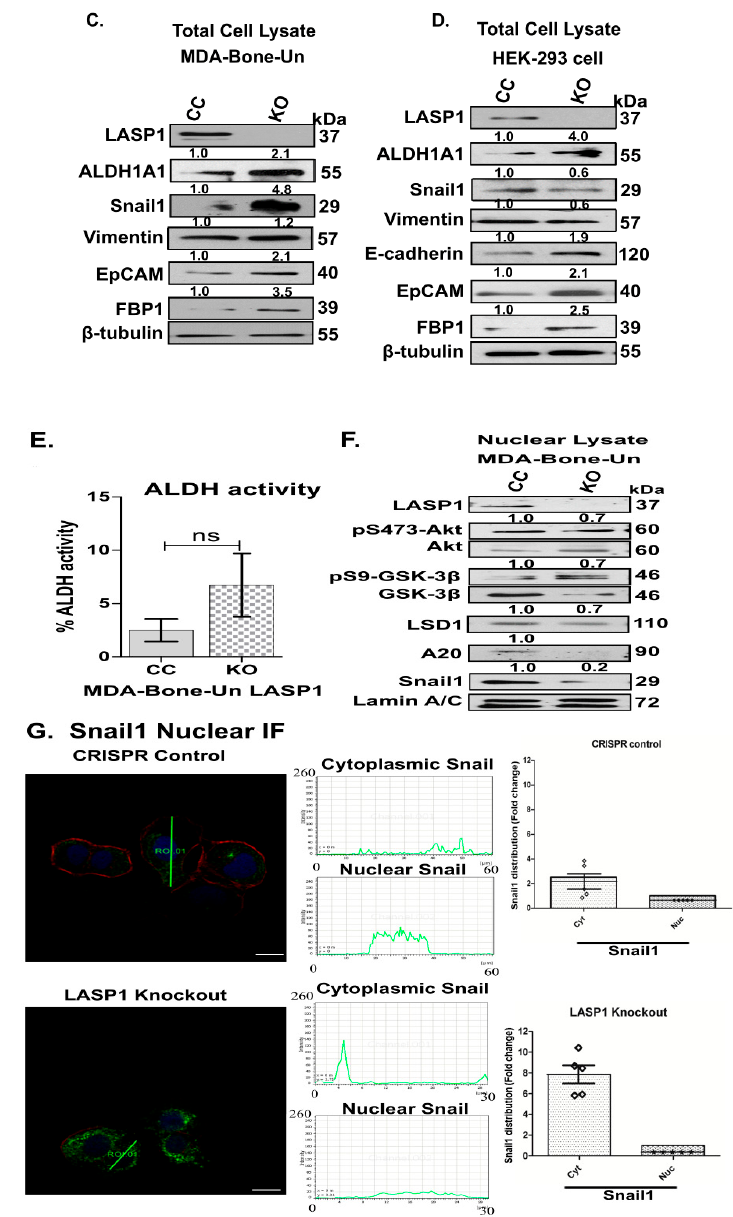
Figure 5. Genetic ablation of LASP1 impairs Matrigel invasion ability and alters the EMT program in TNBC cells. ( A ) LASP1 was genetically edited out by employing the CRISPR-Cas9 approach in MDA-Bone-Un cells. Left panel: The CC and LASP1-KO MDA-Bone-Un cells were plated in DMEM containing 10% serum. The light micrographs depict the morphology of CC and LASP1-KO cells. Right panel: the knockout of LASP1 was confirmed by Western blotting of total cell lysates of MDA-Bone-Un cells. Moreover, β -tubulin served as the loading control. Scale bar: 50 µM. ( B ) The CC and LASP1-KO MDA-Bone-Un cells (1 × 10 5 cells) were seeded onto the upper chamber and allowed to invade through the Matrigel towards the lower chamber containing 25 nM CXCL12 as the chemoattractant overnight. The Matrigel, along with non-invaded cells in the upper chamber, were cleared off with a rubber policeman. The invaded cells that adhered to the bottom surface were fixed and stained with 0.1% crystal violet. The representative images for each condition were depicted (left panel). The cells in five randomly selected fields were counted and expressed as “Mean ± SD”, and the fold invasion is calculated and plotted (right panel); n = 3. Scale bar: 50 µ M. ( C,D ) Altered epithelial and mesenchymal marker profile upon knockout of LASP1. Moreover, 25 µ g of total cell lysate from CC and LASP1-KO